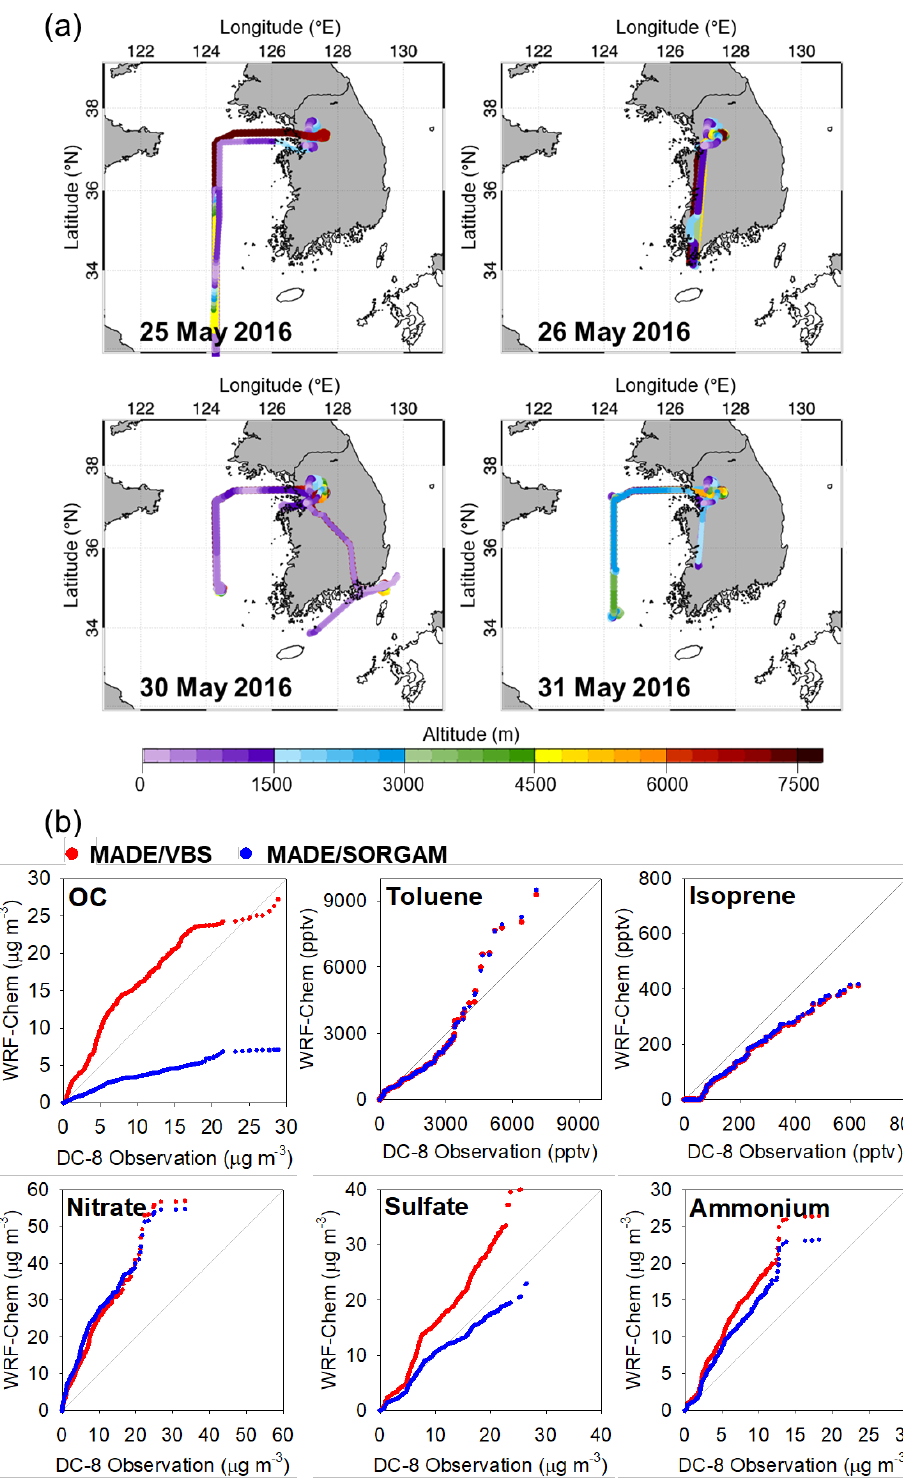
Figure 12. ( a ) NASA DC-8 flight pathways of 4 long-range transport dominant cases (25, 26, 30, and 31 May 2016) during the KORUS-AQ campaign; ( b ) Quantile-Quantile plots for KORUS-AQ DC-8 aircraft PM1 measurements vs. WRF-Chem results for SO 42− , NO 3− , NH 4+ , and OC, simulated from two aerosol modules, MADE/VBS and MADE/SORGAM, respectively, over the long-range transport dominant period (25–31 May) during the KORUS-AQ campaign.